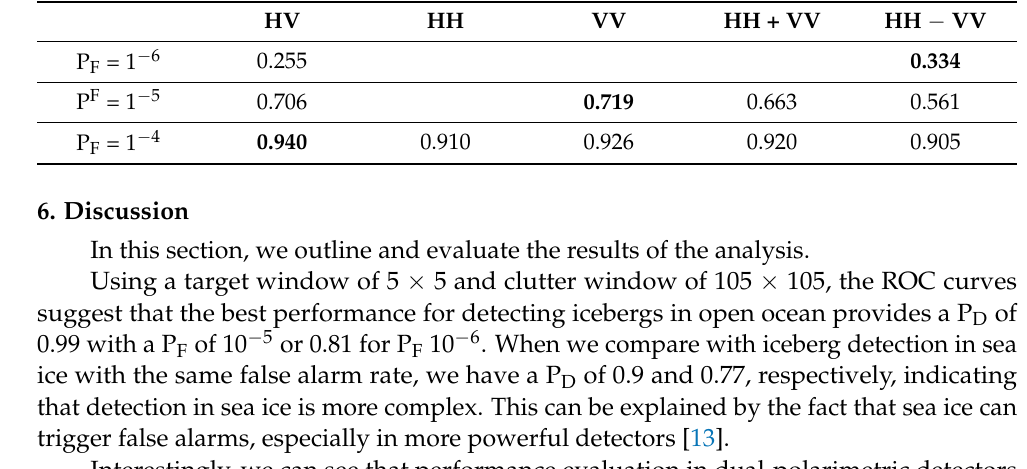
Table 7. Probabilities of detection for intensities sea ice. Bold numbers indicate highest P D